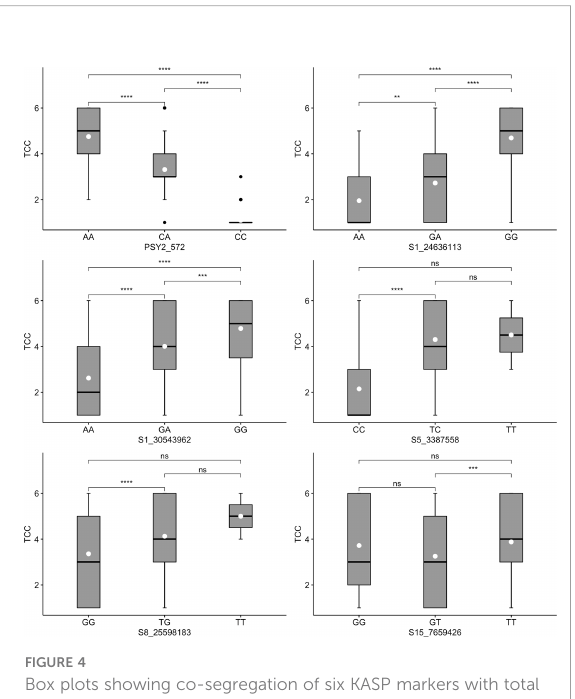
FIGURE 4 Box plots showing co-segregation of six KASP markers with total carotenoids content (TCC). ****, ***, ** signi fi cant at p ≤ 0.0001, p ≤ 0.001 and p ≤ 0.01, respectively; ns = non-signi fi